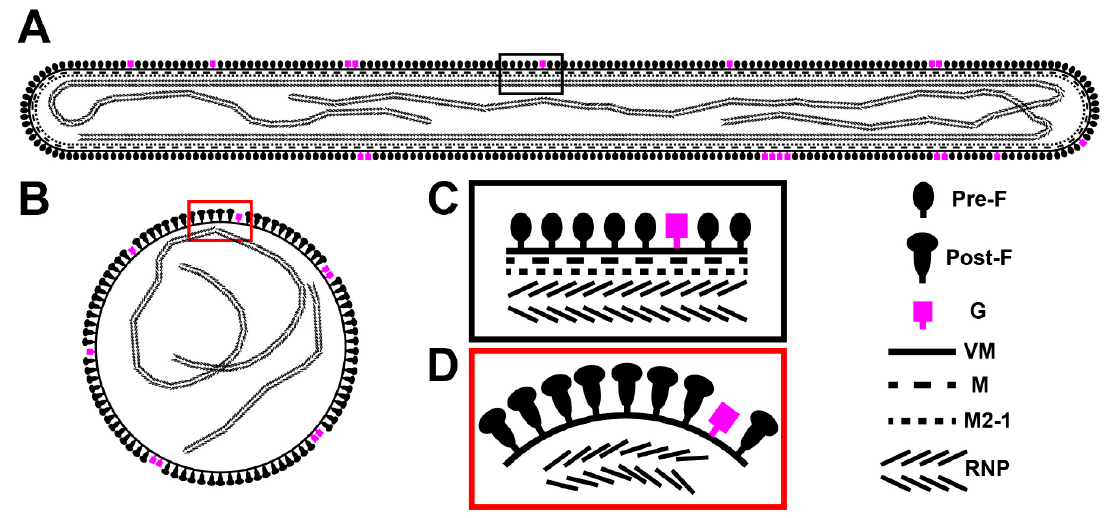
Figure 10. RSV morphology model. A schematic representation of a filamentous ( A ) and a spherical ( B ) RSV viral particle. Enlarged views of the boxed regions in ( A ) and ( B ) are shown in ( C ) and ( D ), respectively. The structure of G and the ratio of G to F are unknown. In the filamentous particle ( A , C ), F is in the prefusion form with matrix (M) lining the viral membrane (VM). M2-1 acts as a linker protein between M and the RNP. In the spherical particle ( B , D ), F is in the postfusion form while M is detached from the viral membrane. RNP is disordered and not linked by M2-1 to the matrix protein.